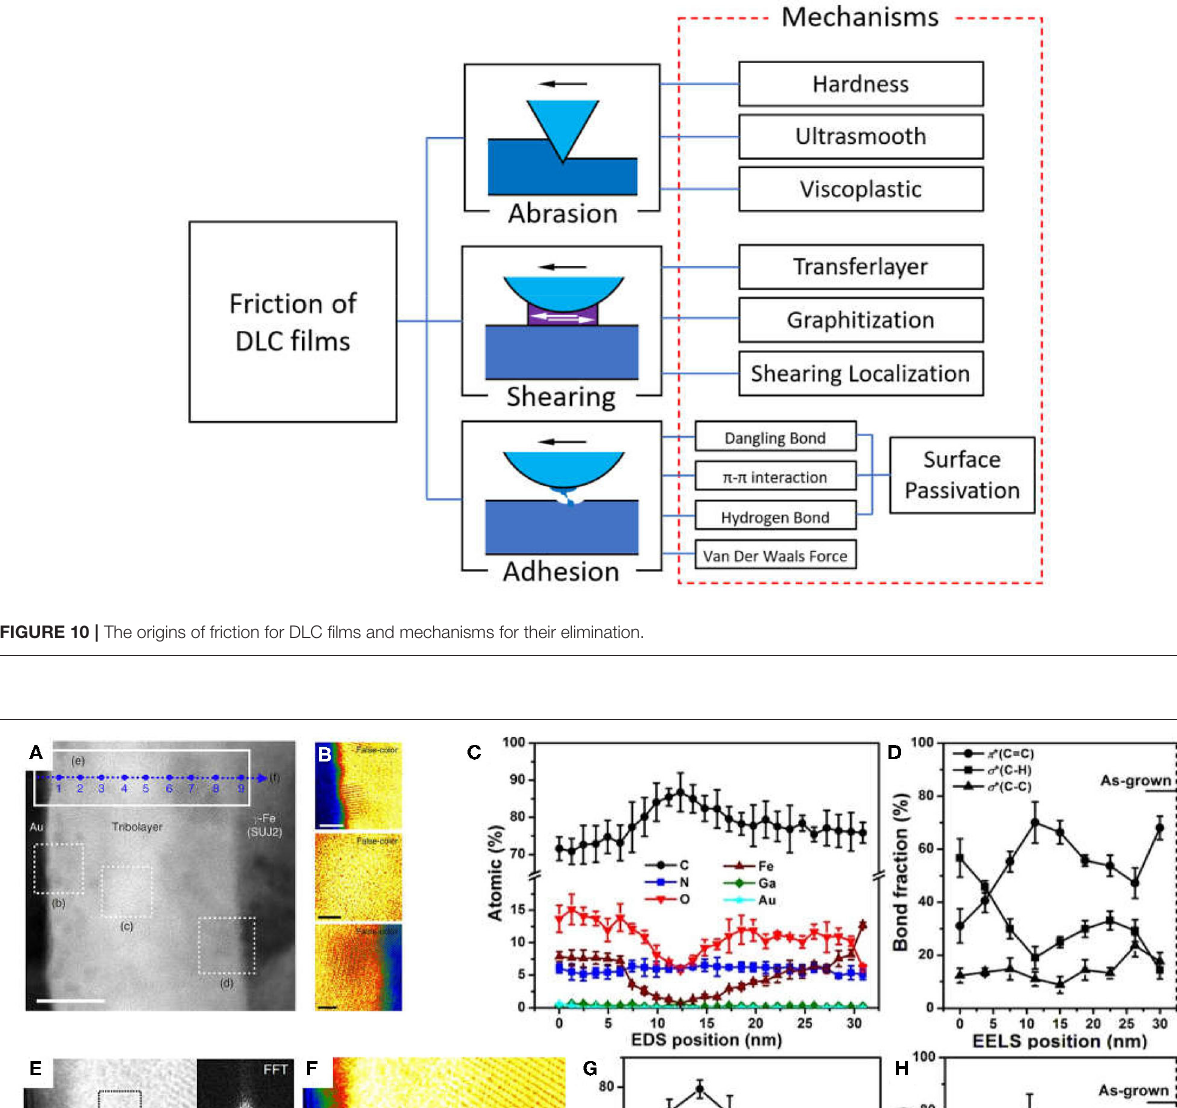
Frontiers in Mechanical Engineering |